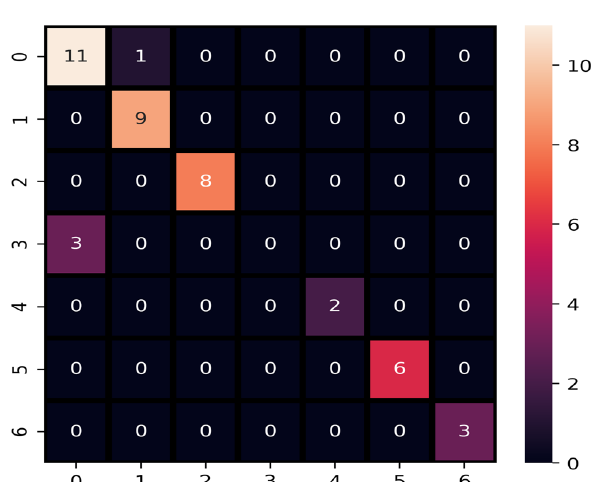
Figure 5. Confusion matrix of LVTrees after applying Chi2